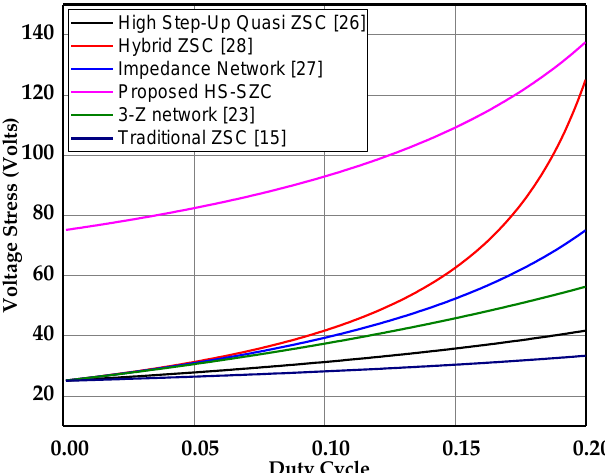
Figure 14. Comparison of the voltage stress for the conventional and proposed converter at the input voltage of V I = 25 V.